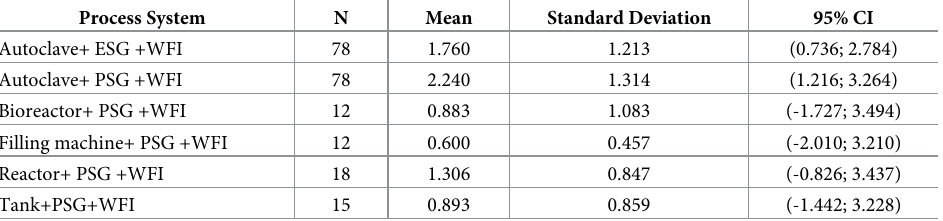
Table 4. Descriptive statistics (n, mean, standard deviation, and 95% confidence intervals) of process systems with a concentration of NCGs below